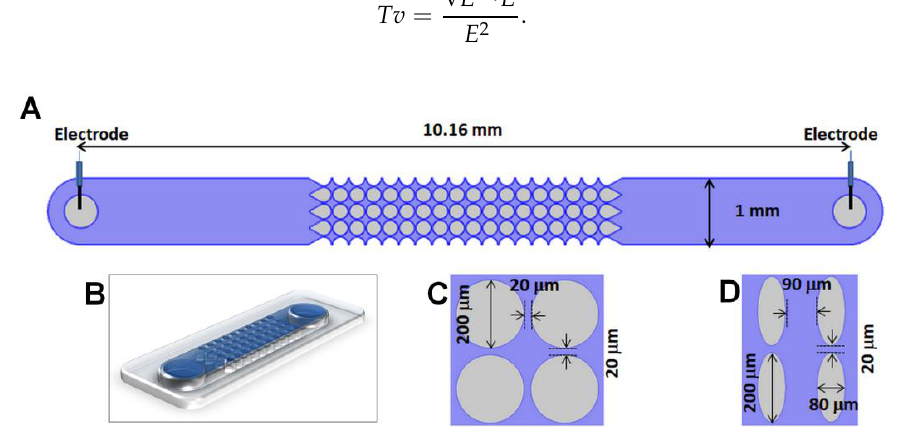
Figure 2. Schematic representation of one insulator-based dielectrophoresis (iDEP) channel employed in this study. ( A ) Top view of a full channel for design Circle-200-220. ( B ) 3D representation of the channel. For the two designs analyzed in this study, an illustration of four insulating posts with dimensions is included: ( C ) Circle-200-220, ( D ) Oval-200-220&80-170. Design names illustrate post size and post spacing.